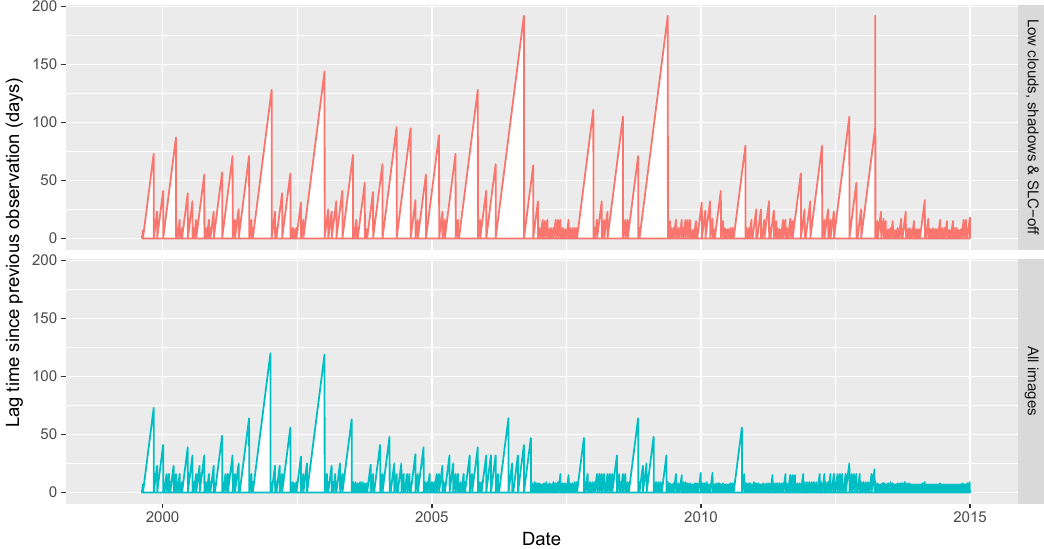
Figure 12. Lag time between successive Landsat images, based on all images available and after optimization to reduce clouds, shadows, and SLC-off interferences.